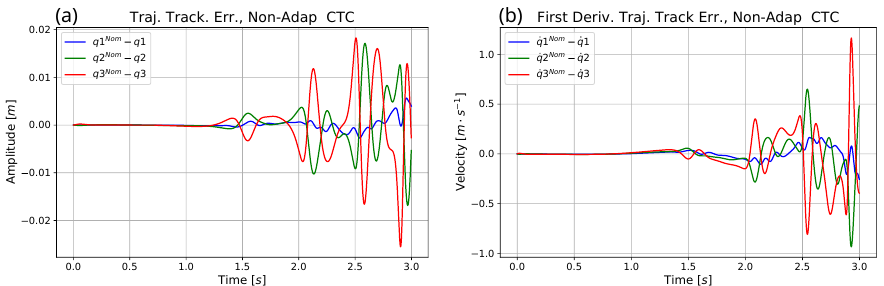
Figure 12. Trajectory tracking error ( a ) and its first time derivative ( b ) for the non-adaptive CTC controller using the identified